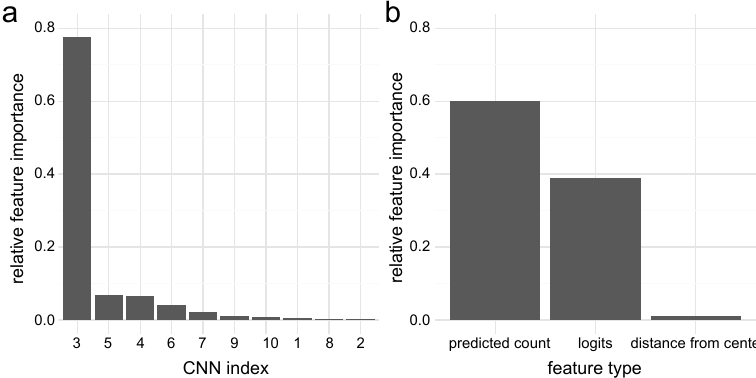
Figure 6. Feature importance for ensemble model features grouped by CNN index ( a ) and feature type ( b ). Ensemble models were either CatBoost or XGBoost tree-based ensembles trained for classifying false-positive and true-positive seal detections. Models were derived from a hyperparameter search using a training set with the logits, predicted seal counts, and distances from crop centers from the output of 10 U-Net CNNs at the validation and expert-selected test sets. Feature importances were obtained via Shapley scores at the validation portion of the random crops test